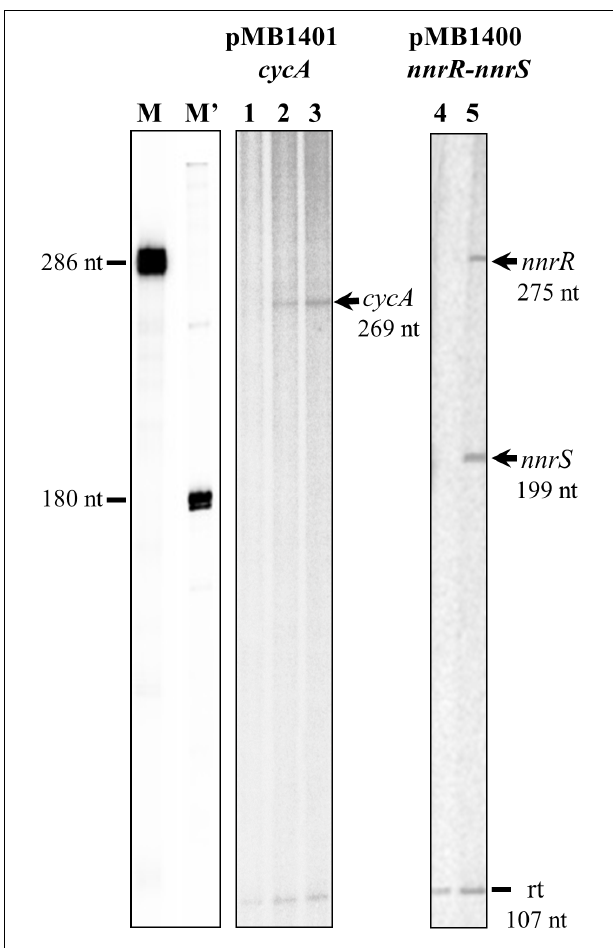
FIGURE 4 | IVT activation of nnrR , nnrS and cycA genes by FixK 2 . Plasmids pMB1400 and pMB1401 were used for a multiple-round IVT activation assay with purified FixK 2 protein (no protein, lanes 1, and 4; 1.25 µ M, lane 2, and 5; 2.5 µ M, lane 3) and RNA polymerase from B. diazoefficiens . RNA size markers (M, M (cid:48) ) were produced as described earlier (Mesa et al., 2005). The positions of the FixK 2 -dependent transcripts are marked with arrows. A vector-encoded transcript of 107 nucleotides (reference transcript) which serves as internal control appears in all lanes. Transcription products generated from each promoter were run on different gels. nt, nucleotides; rt, reference transcript.